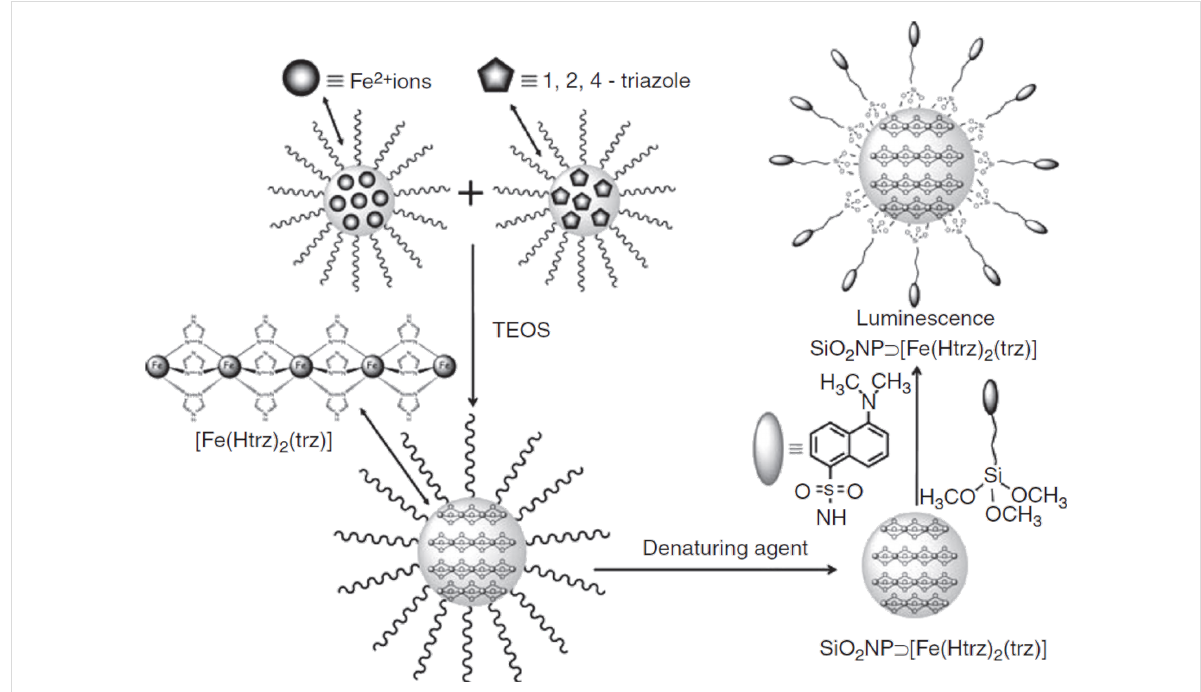
Figure 2: Synthesis route and schematic representation of the luminescent, SCO, SiO 2 nanoparticles. Reproduced with permission from [21], copy- right 2011 Wiley-VCH.